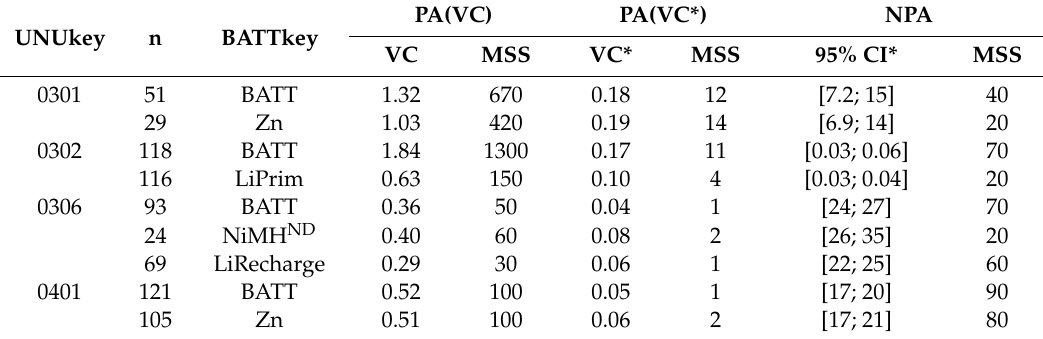
Table 2. Comparison of the approaches to determine the MSS with the PA using the original PA(VC) and bootstrap coe ffi cient of variation PA(VC*) as well as the